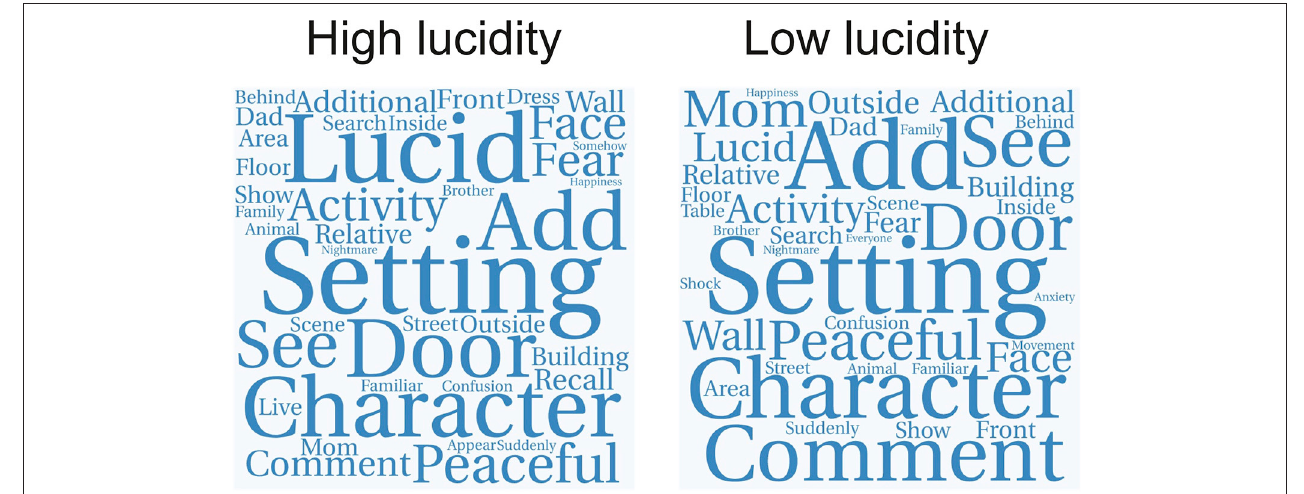
FIGURE 6 | Word clouds for the top 40 most frequent terms in dream reports of high (left) and low (right)